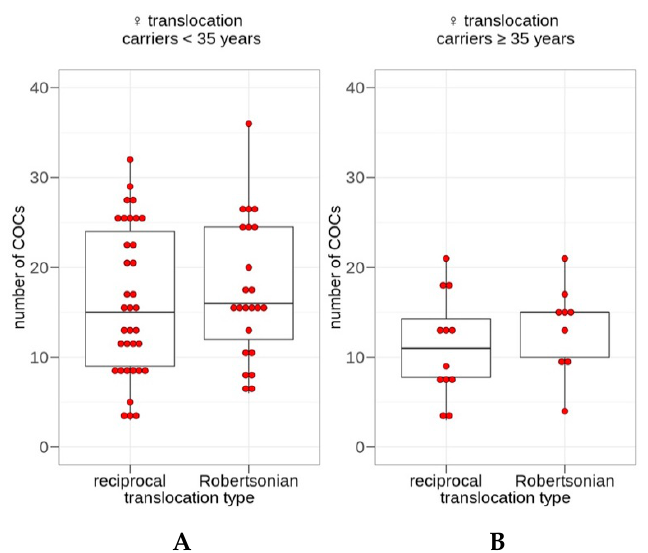
Figure 3. Box plots of the number of cumulus–oocyte complexes (COCs) retrieved after controlled ovarian hyperstimulation in female translocation carriers aged <35 ( A ) and ≥ 35 ( B ) years. The lower whisker represents the smallest observation greater than or equal to the lower hinge—1.5 × IQR; the lower hinge represents the 25% quantile; the line through the box represents the median, 50% quantile; the upper hinge represents the 75% quantile; the upper whisker represents the largest observation less than or equal to the upper hinge + 1.5 × IQR. No significant difference between the subgroups of female reciprocal and Robertsonian translocation carriers either <35 ( A ) or ≥ 35 ( B ) years of age was detected (Mann–Whitney U test, U = 364, p = 0.5452 and U = 40, p = 0.3344, respec-tively).